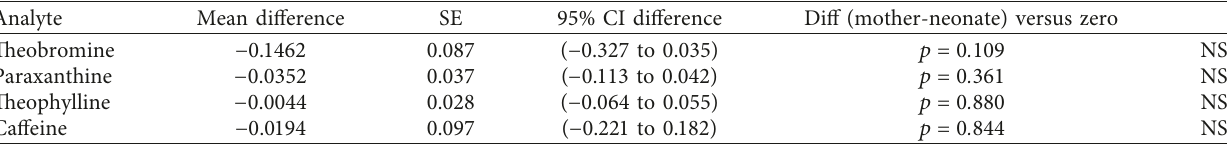
Table 4: t -Test analysis for mean comparison between maternal and neonatal caffeine and metabolite concentration. Statistical analysis was done by comparing difference of concentrations mother-child versus zero difference.